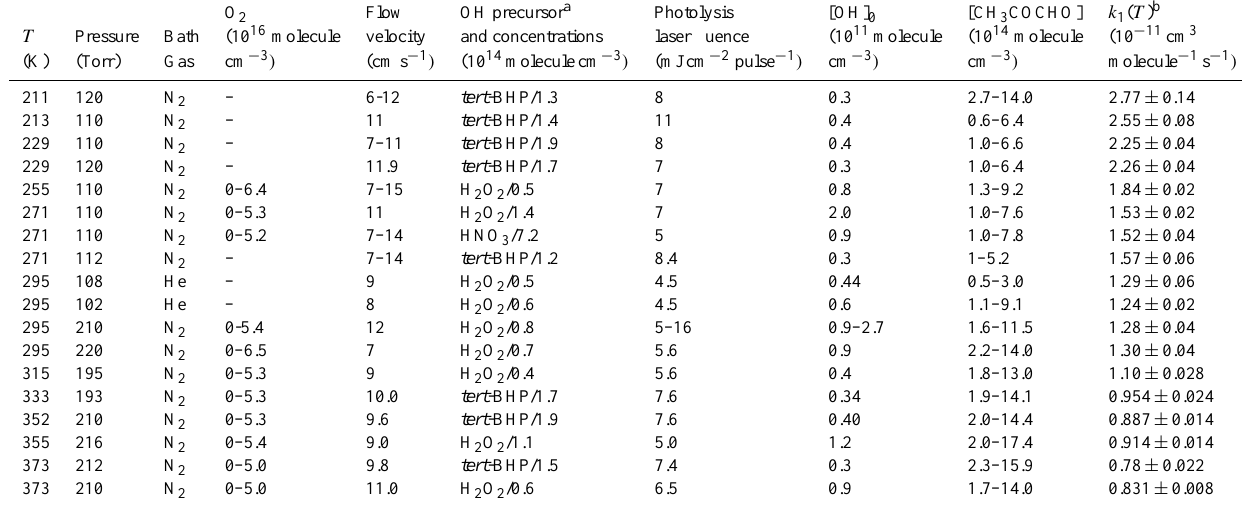
Table 2. Summary of experimental conditions and measured rate coefficients for the OH + CH 3 COCHO (methylglyoxal) reaction, k 1 ( T